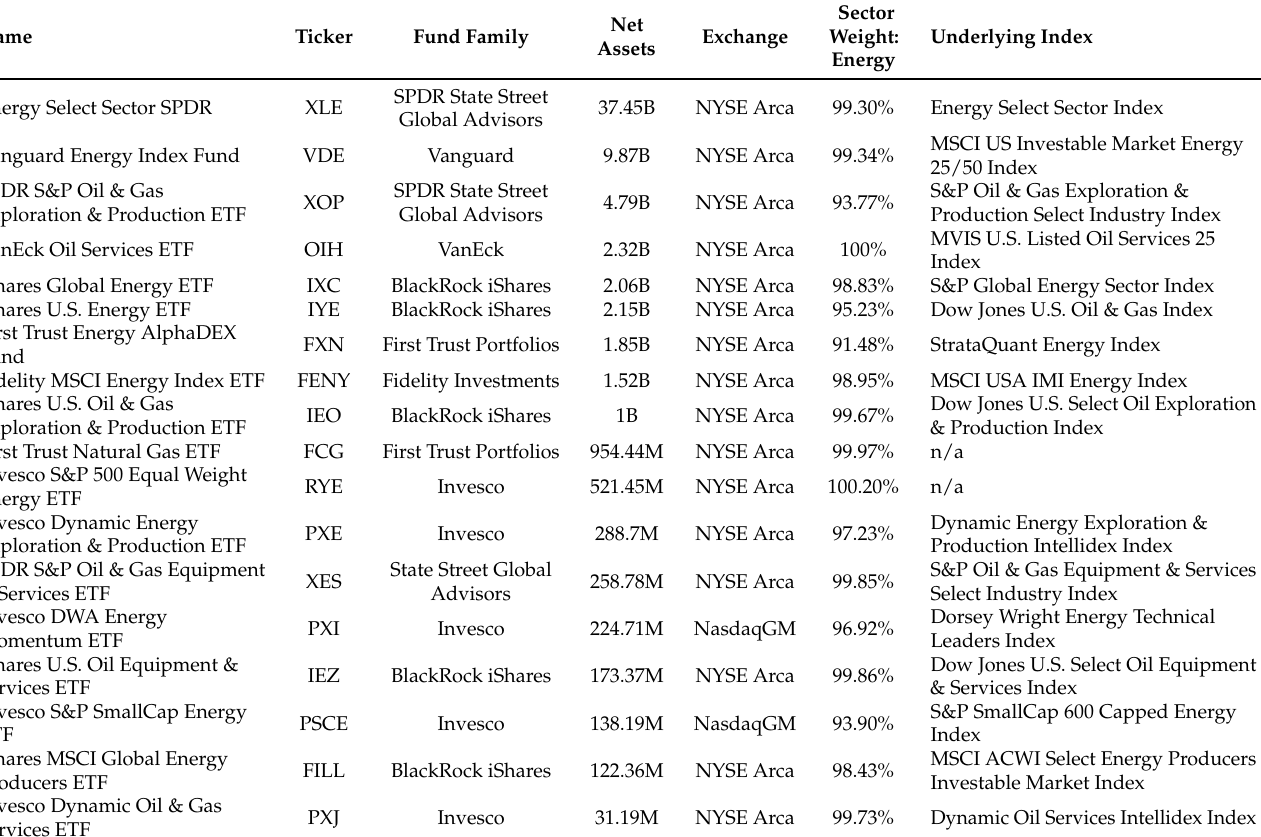
Table A1. The financial series included in the study.